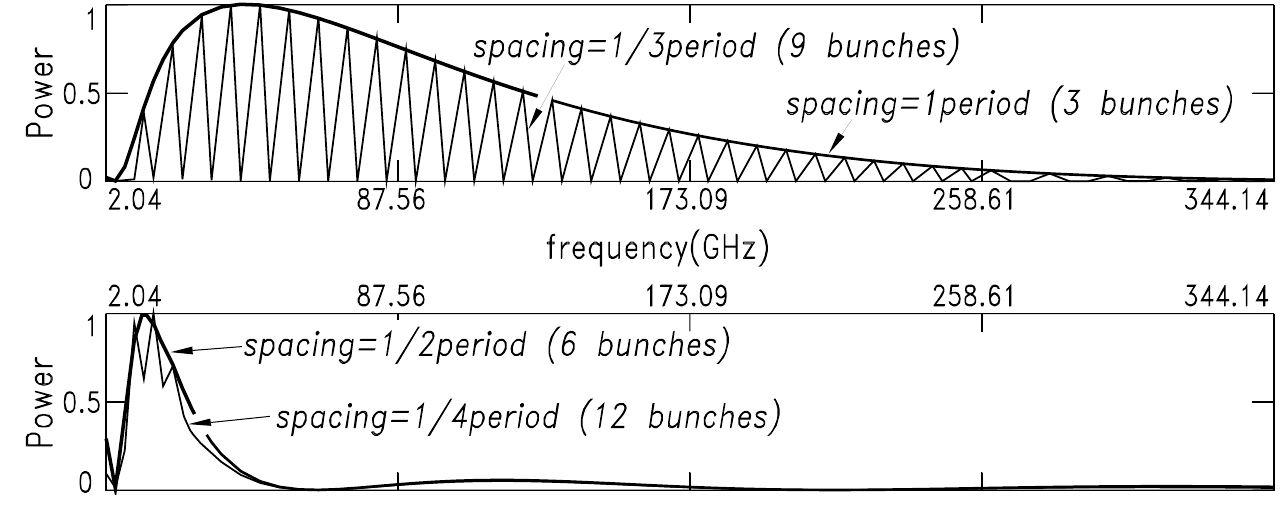
FIG. 13. Normalized spectrum for a train of bunches with spacing 1, 1 = 2 , 1 = 3 , and 1 = 4 the wakefield period, normalized to the same maximum value. The shape of the spectrum depends upon the ratio of the wakefield period to the bunch spacing. If this ratio is an odd (top) or even (bottom) number, one can interpret the high frequency spectrum to obtain the rms length. If the ratio is neither odd nor even, the spectrum is so complicated that is likely to be useless for diagnostic purposes. (Here, the train has 3 identical bunches when the spacing is 1 wakefield period, 6 identical bunches when the spacing is 1 = 2 of the wakefield period, 9 identical bunches when the spacing is 1 = 3 of the wakefield period, and 12 identical bunches when the spacing is 1 = 4 of the wakefield